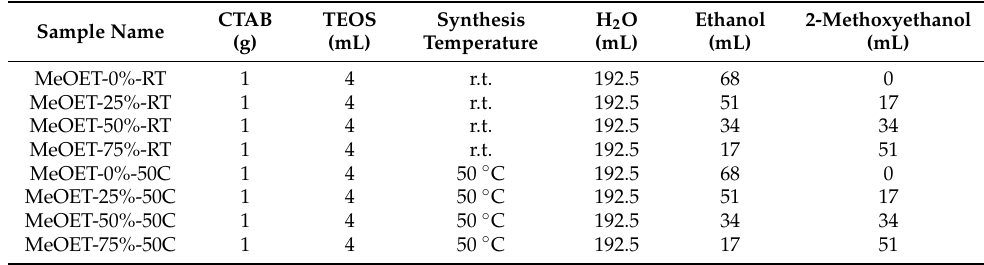
Table 4. Synopsis of the synthesized